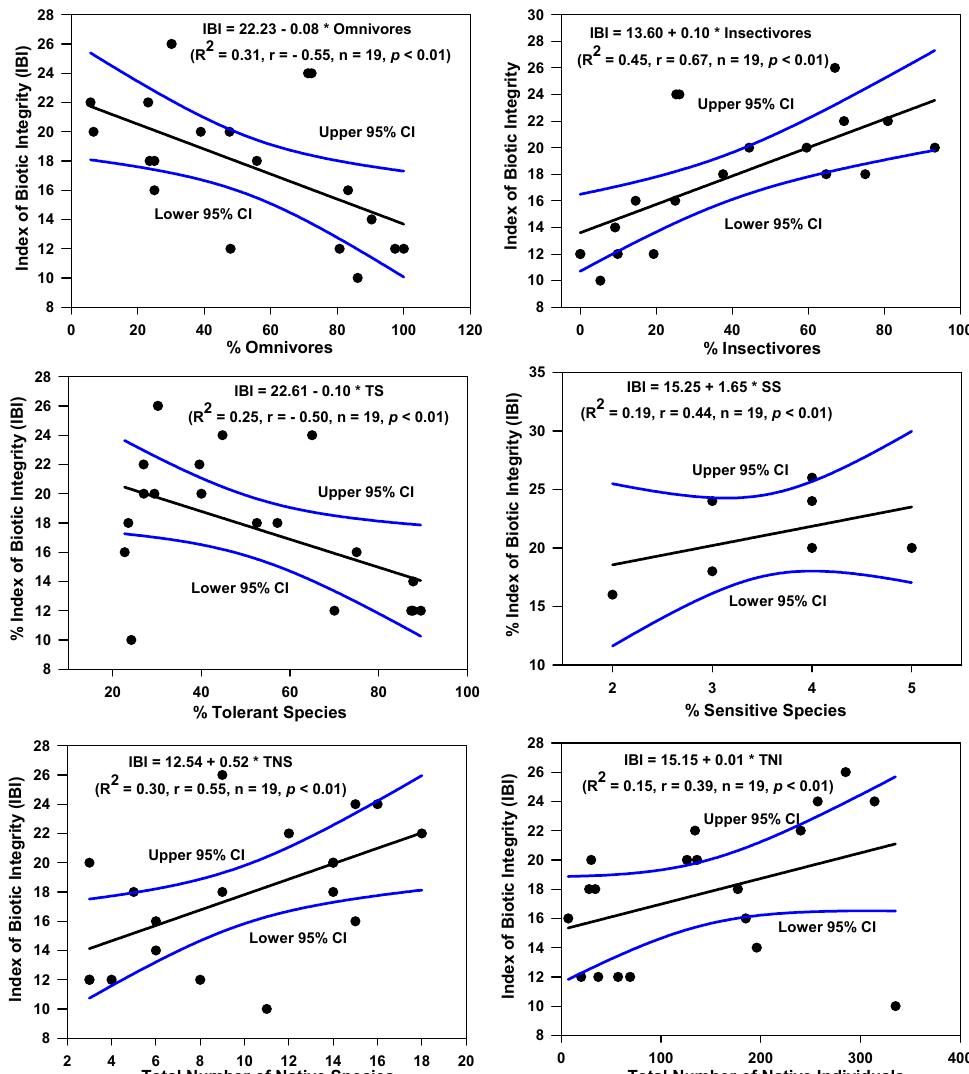
Figure 8. IBI with trophic and tolerance guilds and TNS and TNI in the watershed.